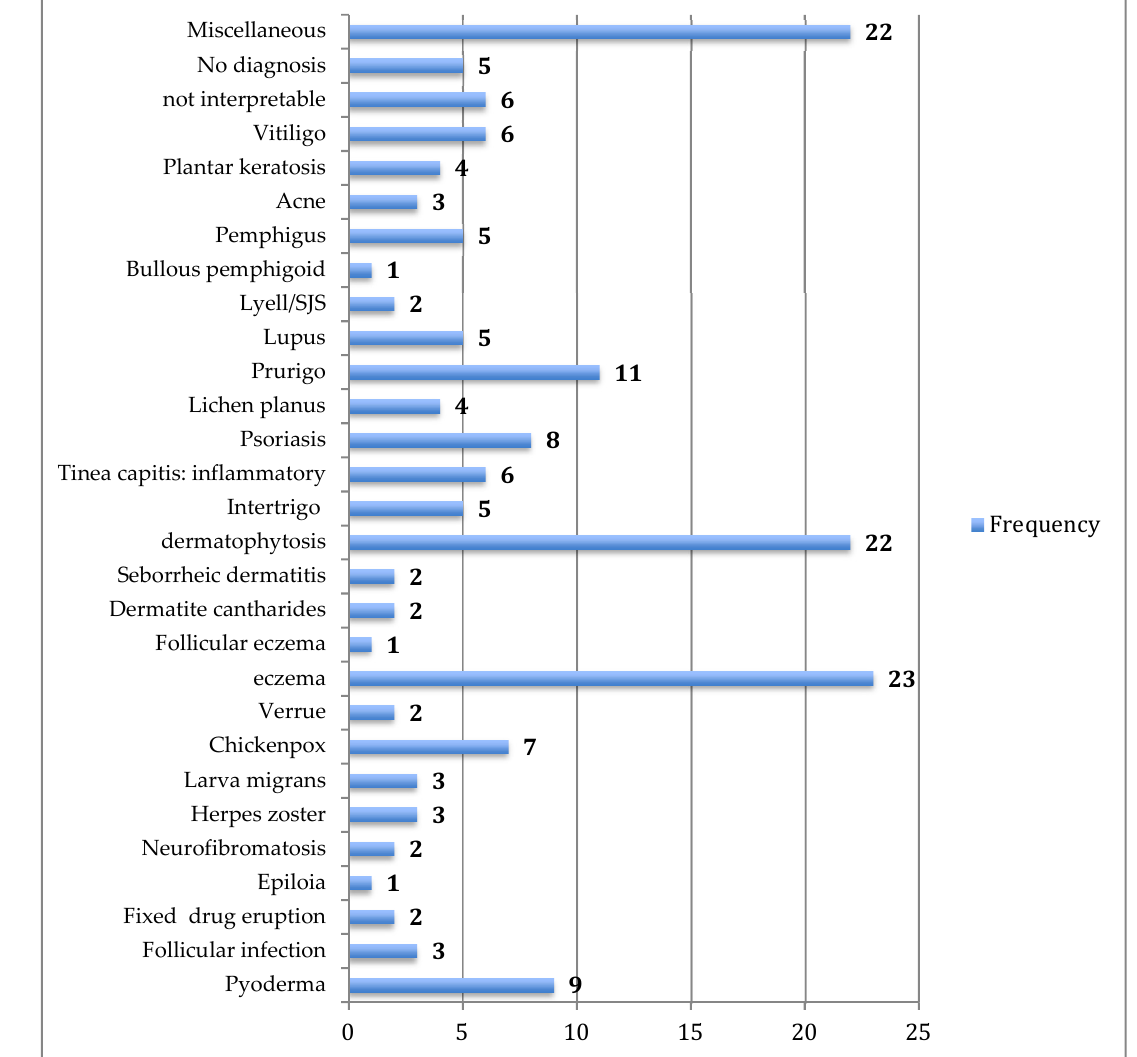
Figure 6. Pattern of skin diseases diagnosed via the platform in 180 cases posted by primary health care workers.